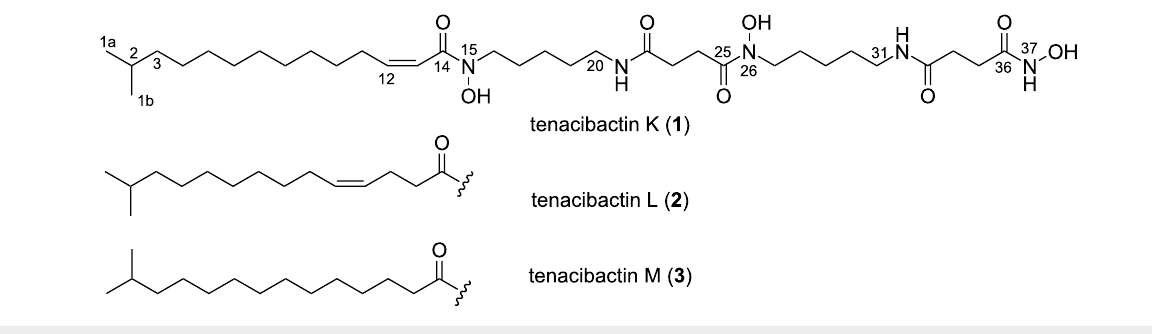
Figure 1: Structures of tenacibactins K–M ( 1 – 3 ).